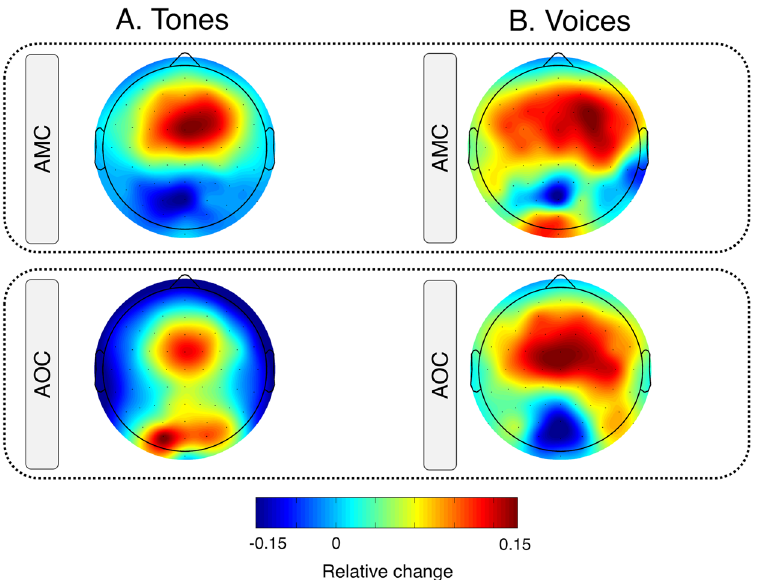
Figure 4. Maps showing the topographical distribution of pre-stimulus alpha power for the different conditions and stimulus types. Values are averaged across the 8–12 Hz frequency band in a time window of 250 ms before stimulus